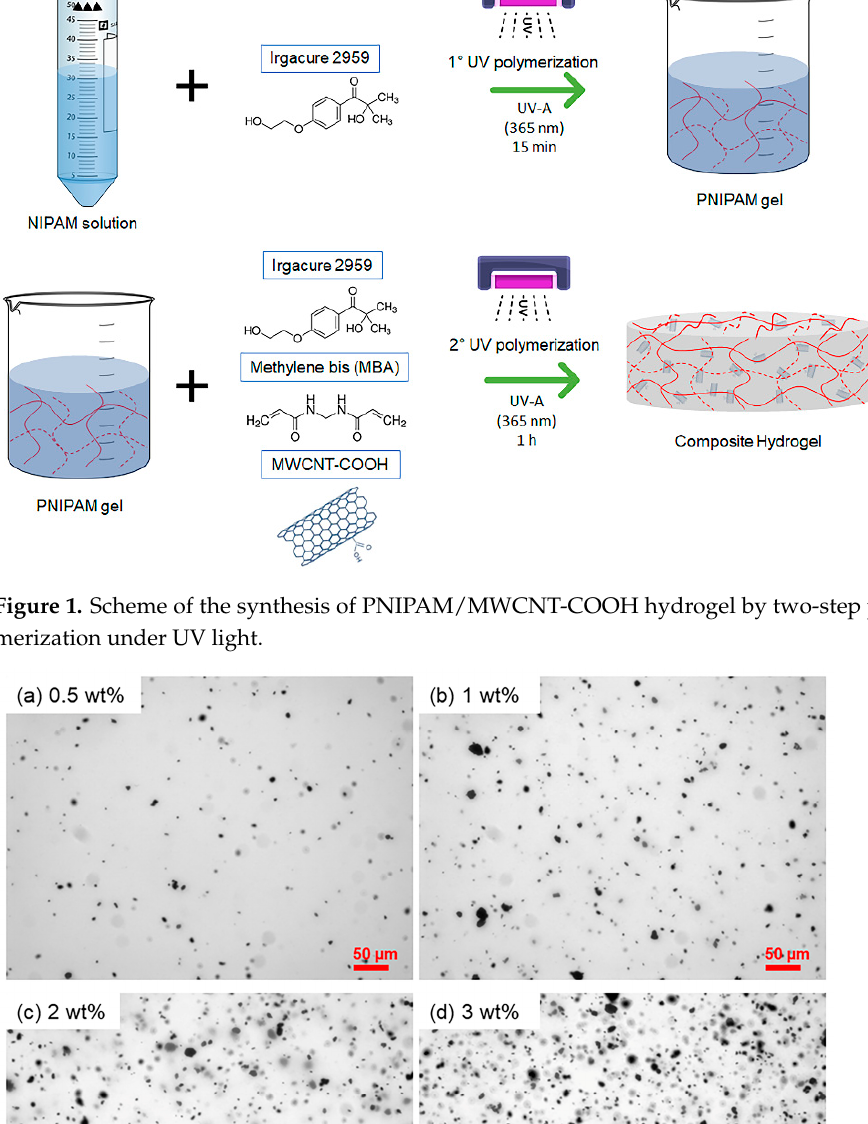
Figure 3. Reaction yield for the PNIPAM/MWCNT-COOH hydrogel synthesis with different nanotube concentrations. 3.2. Hydrogel Swelling Behavior The swelling capacity of hydrogels in aqueous media is strictly related to the presence of hydrophilic functional groups, such as hydrogen-bonding hydroxyl and carboxyl groups, on the polymer chains. These groups bind and retain water molecules, diffusing into the hydrogel network by capillary action and osmotic pressure difference. Figure 4 shows the swelling ratio and water content of PNIPAM/MWCNT-COOH